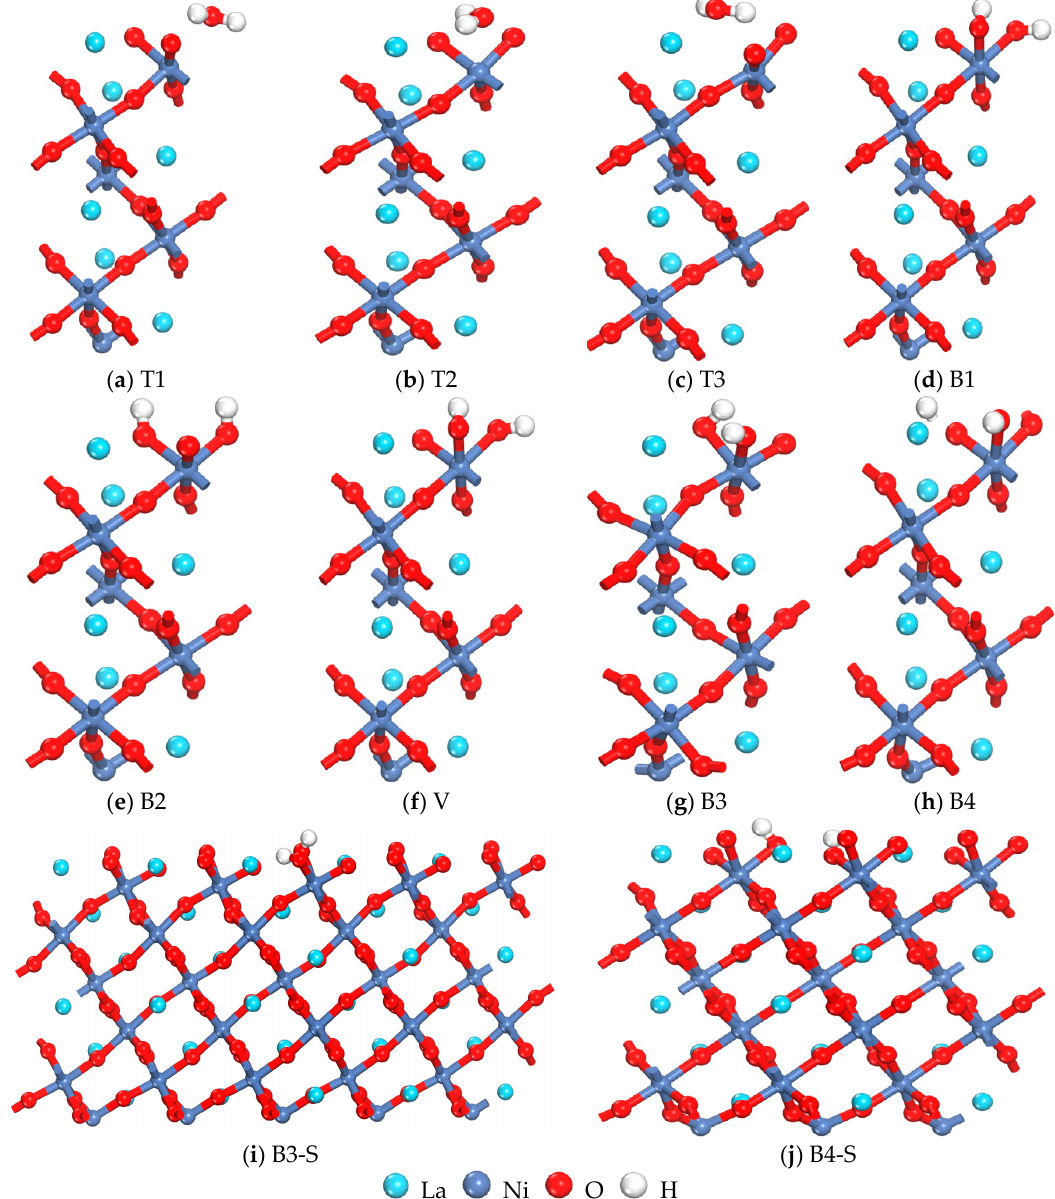
Figure 3. The optimized geometrical structure of LaNiO 3 (001)/H 2 in Termination I.